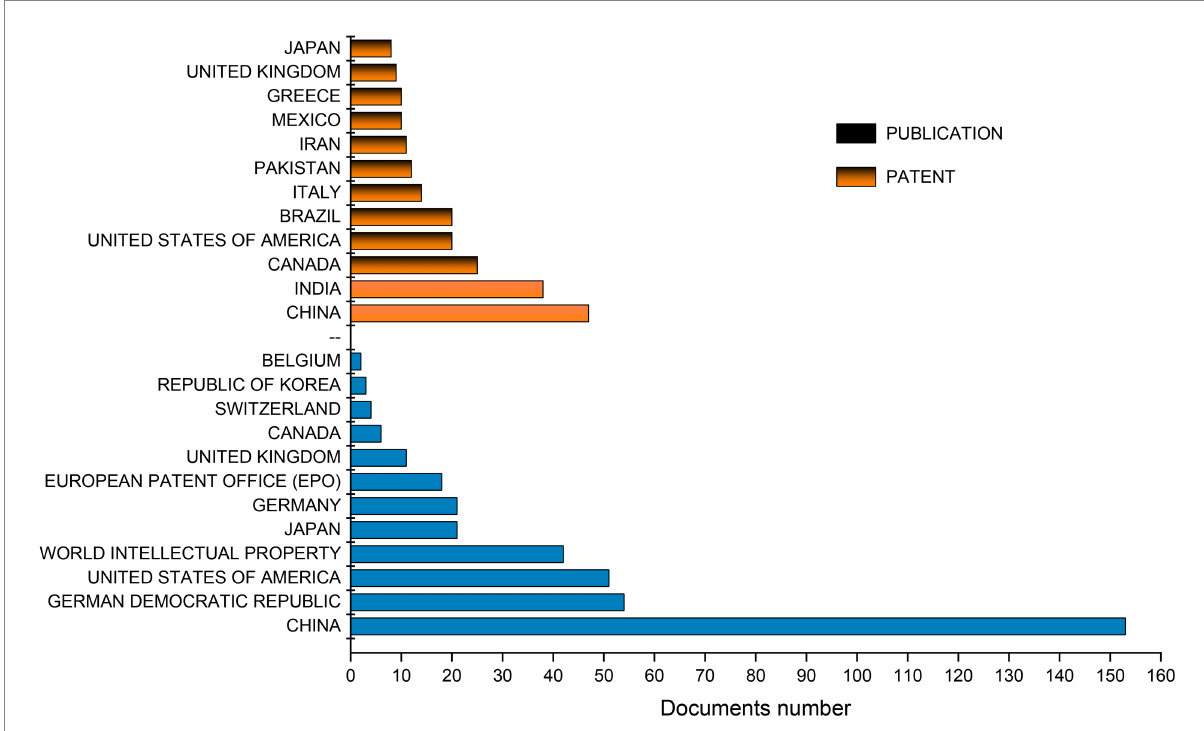
FIGURE 4 Main countries that most published articles and filed patents using the terms “fermentation” and “single cell protein” or “single-cell